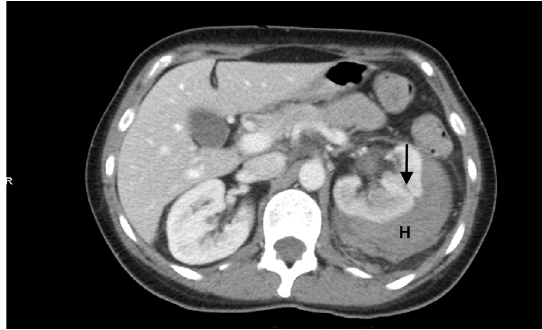
Figure. Computed tomography of the abdomen three days following extracorporeal shockwave lithotripsy and laser lithotripsy procedures showing a laceration to the lateral aspect of the mid left kidney (black arrow) and a hematoma on the posterior and lateral borders of the left kidney